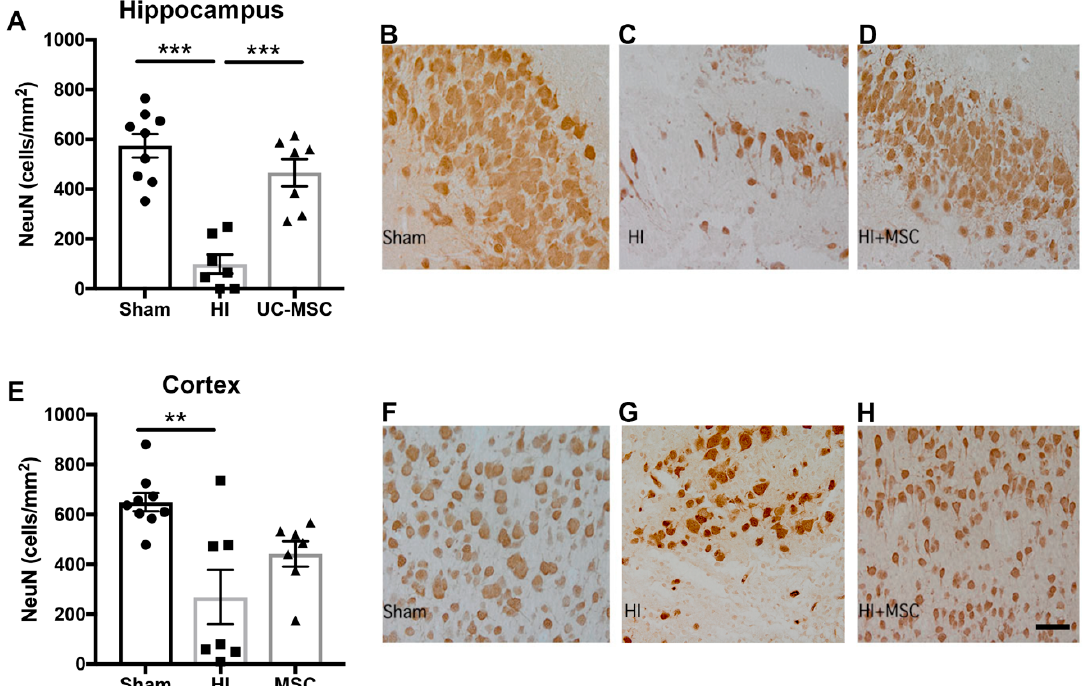
Figure 3. Neuronal cell counts are reduced in the hippocampus following neonatal HI brain injury and improved by UC-MSC treatment. ( A ) Neuronal (NeuN) cell counts in the hippocampus. Representative images of NeuN staining in the hippocampus for ( B ) sham, ( C ) HI and ( D ) UC-MSC treatment; ( E ) neuronal (NeuN) cell counts in the somatosensory cortex. Representative images of NeuN staining in the somatosensory cortex for ( F ) sham, ( G ) HI and ( H ) UC-MSC treatment. All images were taken at 400 × magnification, scale bar = 500 µ m ( n = 7–9 rats per group, ** p < 0.01, *** p < 0.001).